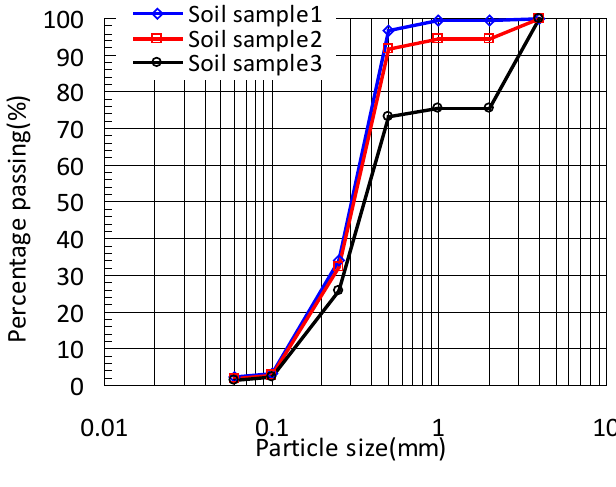
Figure 2. Particle-size distribution